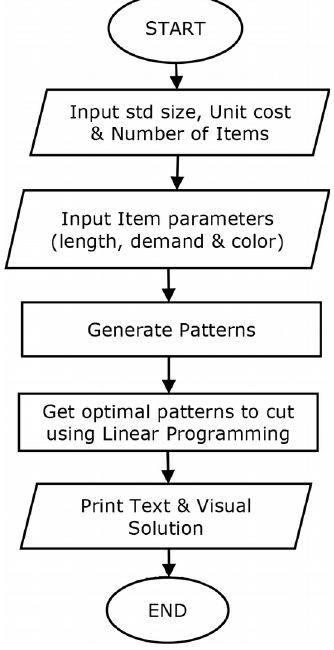
Figure 3. Flow Chart for the GB Cutting Stock